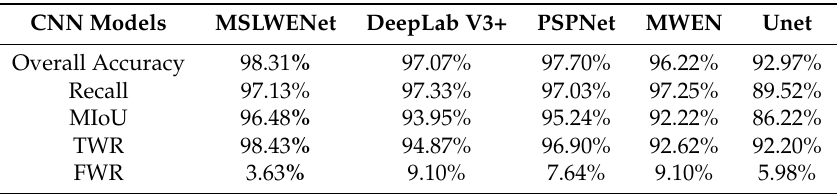
Figure 9. Performance comparison of different models for lake water extraction from large intraclass variance regions. ( a(1) – a(6) ) are the raw images in the test set; ( b(1) – b(6) ) are the ground truths to which the raw images correspond; ( c(1) – c(6) ), ( d(1) – d(6) ), ( e(1) – e(6) ), ( f(1) – f(6) ), and ( g(1) – g(6) ) are the extracted results of MSLWENet, DeepLab V3+, PSPNet, MWEN, and Unet, respectively. Table 5. The metrics of the CNN models on the images in Figure